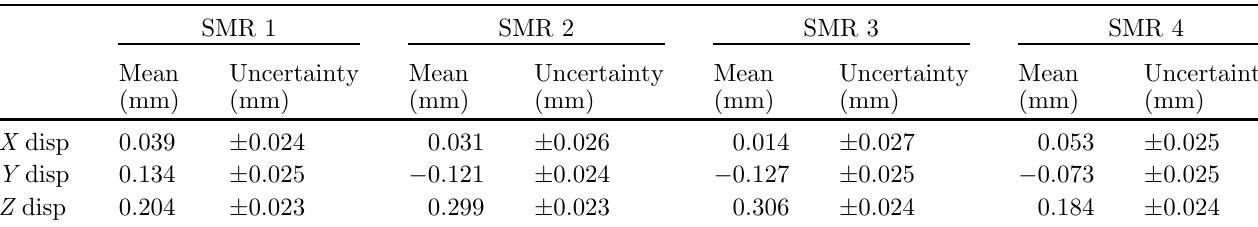
Table 1. Means and uncertainties of SMR measurements at 90